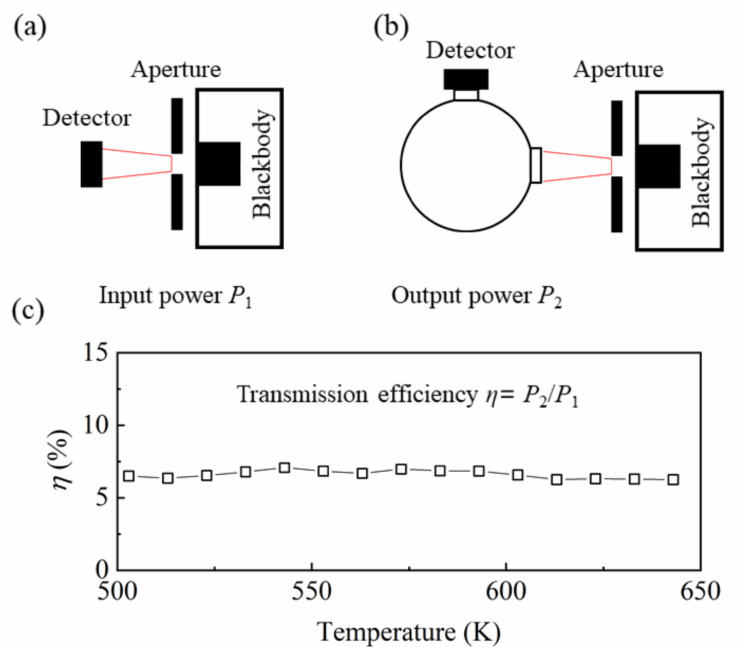
Figure 5. ( a , b ) A schematic of the integrating sphere transmission efficiency calibration method, ( c ) the transmission efficiency of the integrating sphere as a function of the blackbody temperature. Table 1. The thermal properties of the typical insulating materials used in under vacuum.